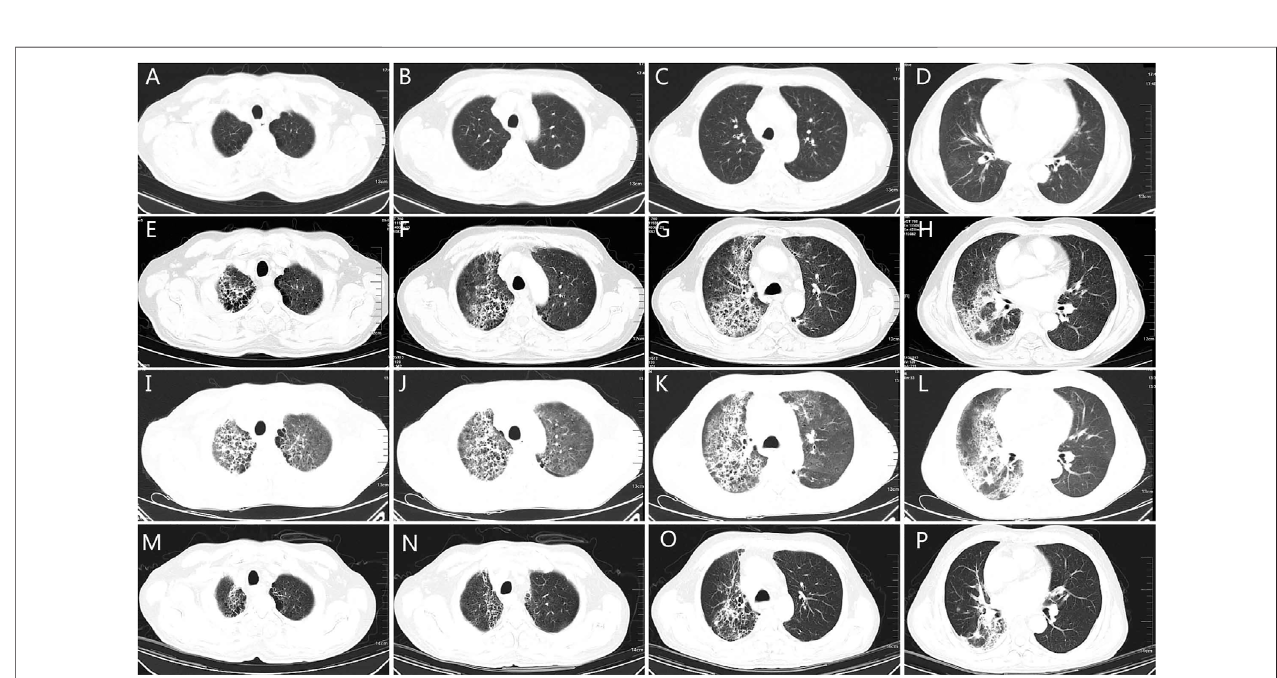
FIGURE 3 | The chest CT of patient two. (A – D) : chest CT showing the lung quality before afatinib. (E – H) : chest CT showing pneumonia 27 days after afatinib therapy,thegrid changesand ground glasshinting onlunginjury. (I – L) :chestCT5 days after discontinuationofafatiniband empirical antibiotics, showingenlarged fi eld of grid changes and pulmonary interstitial edema, indicating the diffused alveolar injury. (M – P) : chest CT 17 days after glucocorticoid therapy, the grid changes and pulmonary interstitial edema reduced signi fi cantly, indicating improvements of lung injury. CT: computed tomography.